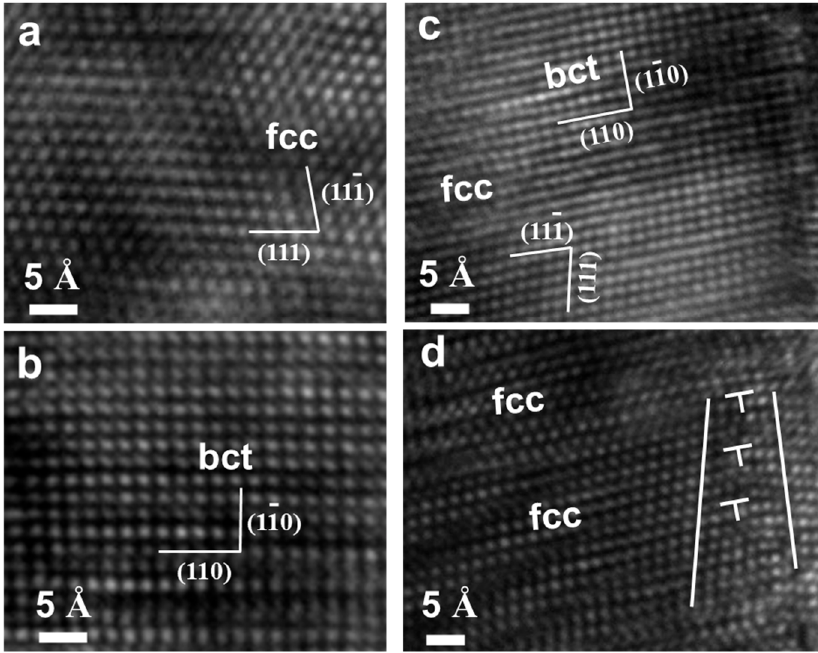
Figure 5. ( a , b ) In situ atomic-scale results show the fcc–bct structure transition. ( c , d ) In situ atomic- scale results show the reversible fcc–bct transition.